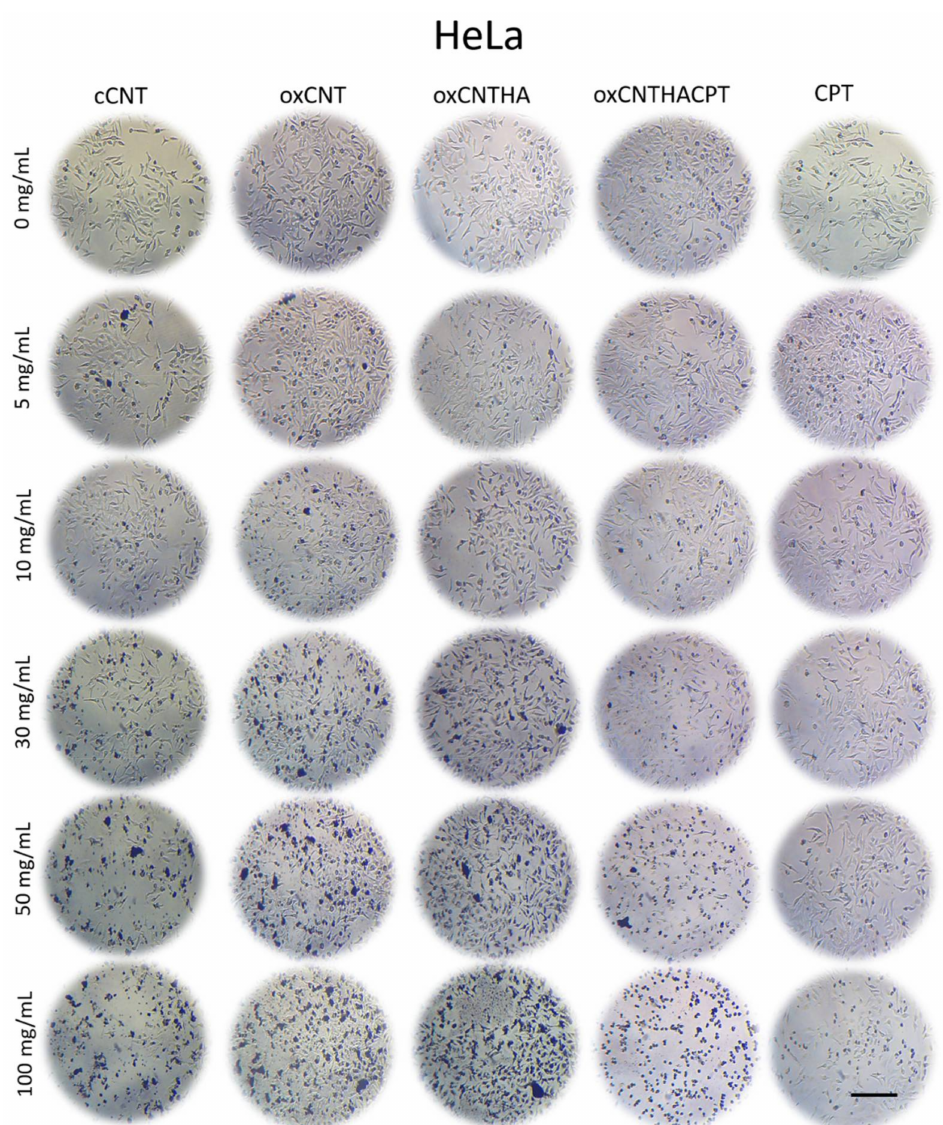
Figure 3. Micrographs of HeLa cells in culture and exposed for 24 h at concentrations of 0, 5, 10, 30, 50, and 100 µ g/mL. Note that the higher the concentration of cCNTs, the greater the agglomeration of the nanoparticles, and the lower the cell confluence. On the contrary, in the oxCNTs and oxCNT–HA treatments, it is observed that the higher the concentration, the nanoparticle agglomerates are less, and the cell confluence does not decrease significantly. Interestingly, in the treatments with oxCNT– HA–CPT and CPT, it was observed that the higher the concentration of the treatment, the lower the cell confluence. The cells detach from the well due to the cytotoxicity of the treatment and change their morphology. However, the toxicity of CPT is lower compared to that of oxCNT–HA–CPT. Scale = 200 µ